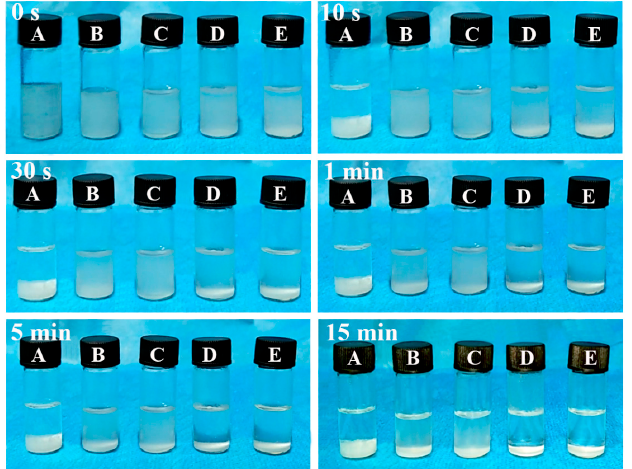
Figure 7. Sedimentation experiments of GdPO 4 ·H 2 O@SiO 2 (A) and PBLG-g-GdPO 4 ·H 2 O with grafting rates of 4.14% (B), 5.93% (C), 13.72% (D) 15.93% (E) at different times in